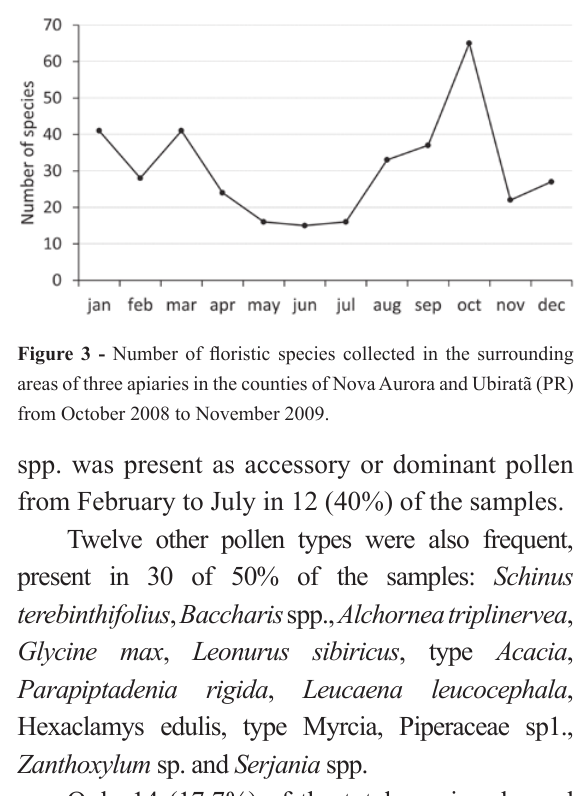
Index of Diversity of Shannon and Simpson based on pollen data from samples of three apiaries located in the counties of Nova Aurora (A) and Ubiratã-PR (B and C).